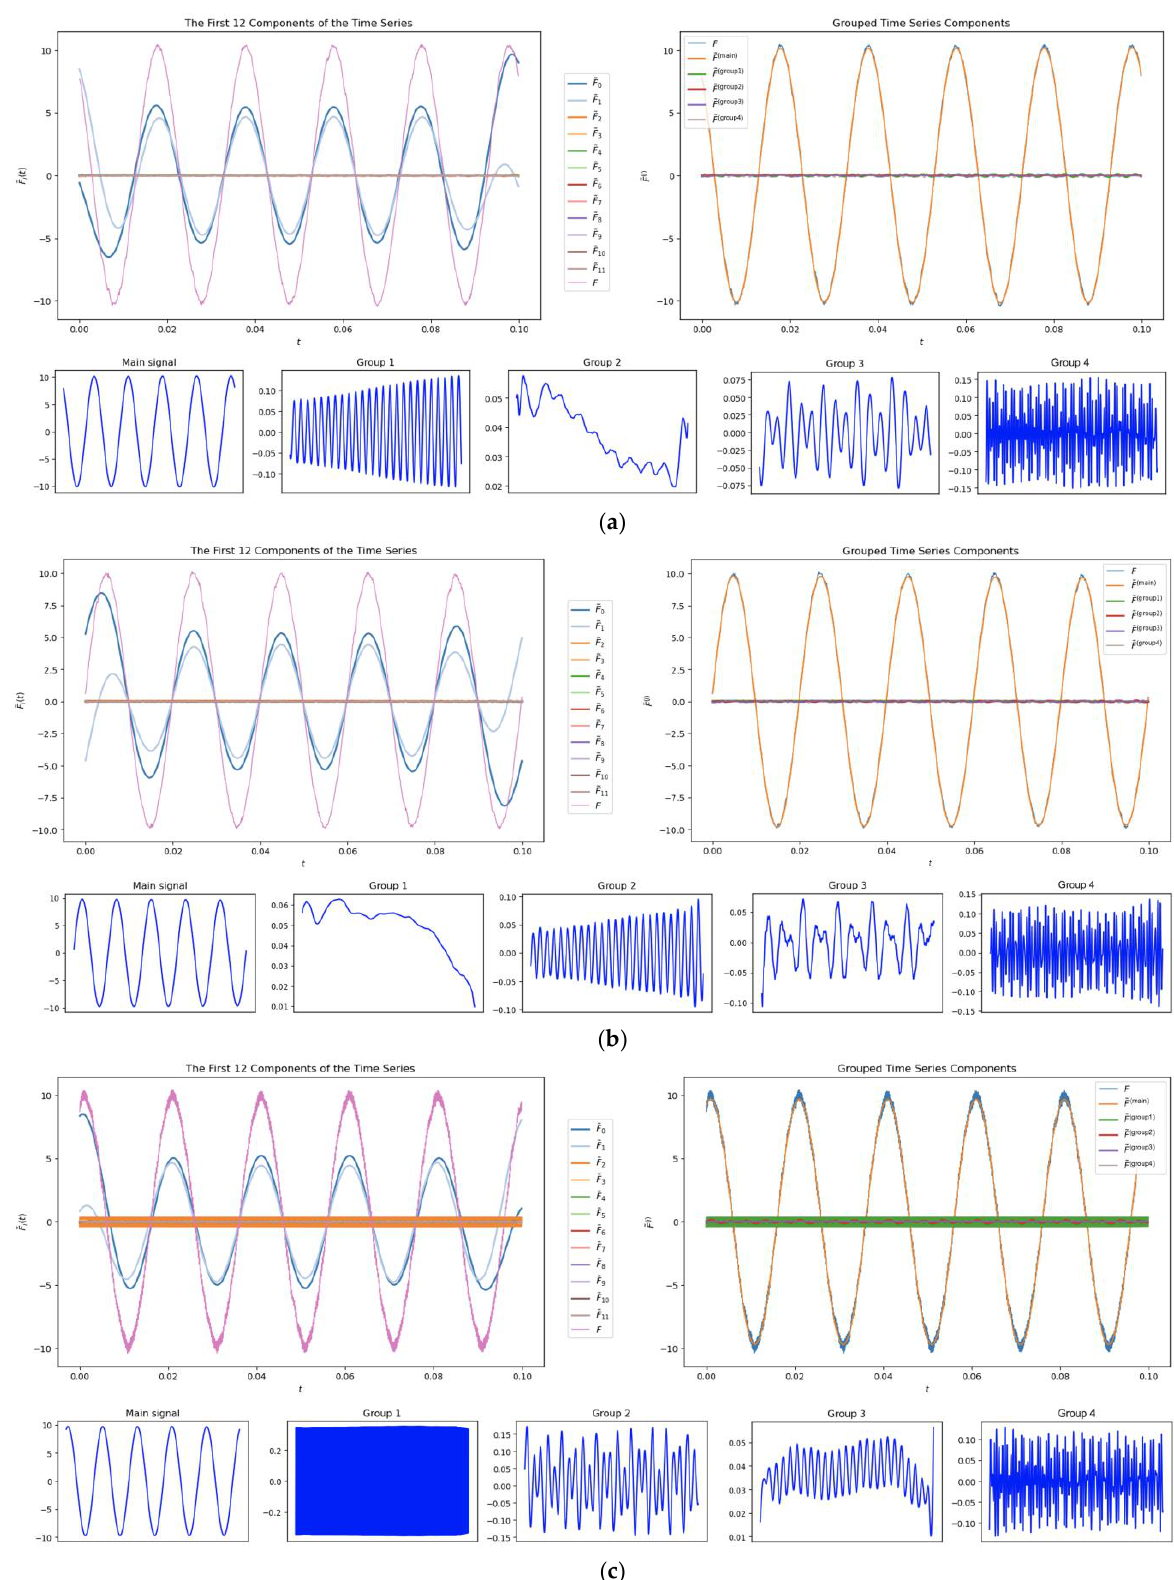
Figure 10. Component grouping results based on visual assessment for phase A of the bearing without faults ( a ), the bearing with one spall ( b ) and the bearing with three spalls ( c ).